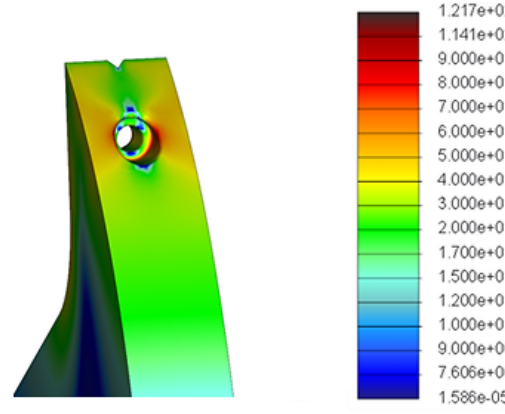
Figure 8 Maximum screw hole tension under crushing